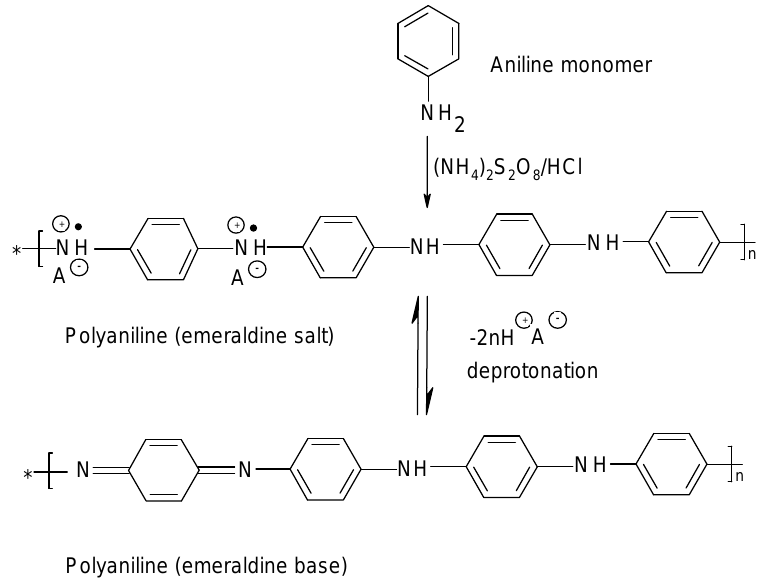
Figure 8. Formation of polyaniline from aniline and its two forms.